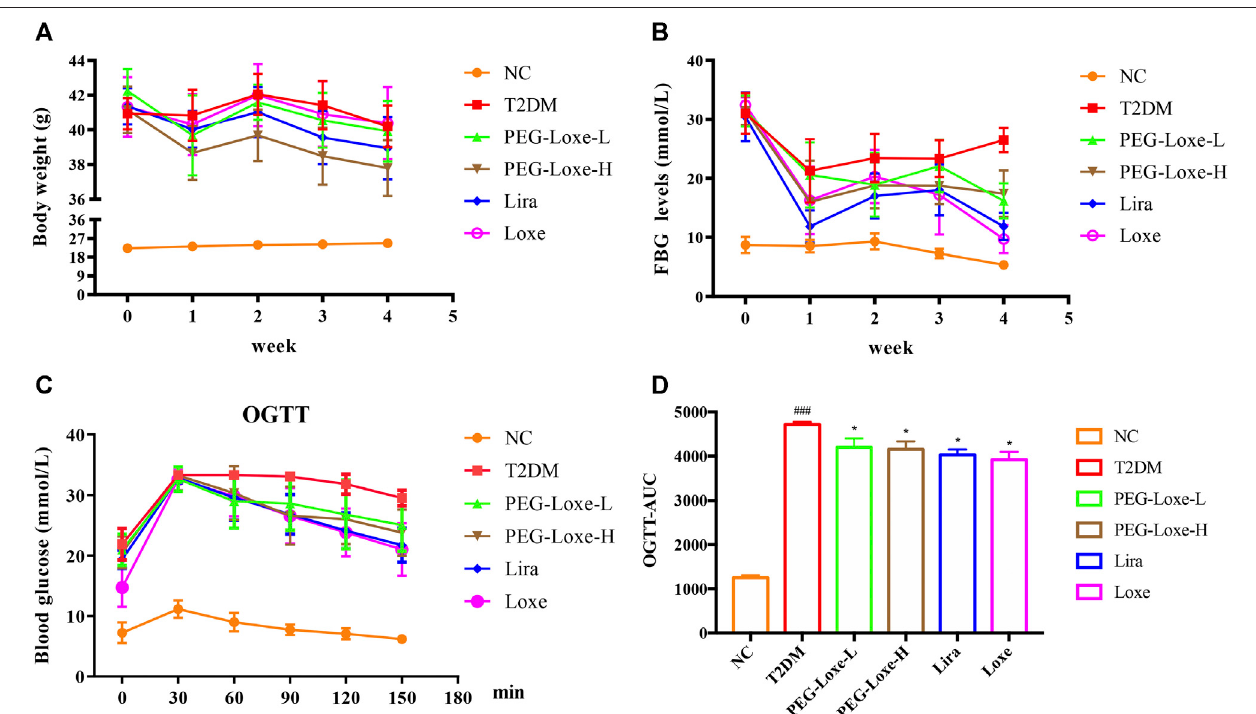
FIGURE 1 | Polyethylene glycol loxenatide (PEG-Loxe) reduces body weight and hyperglycemia in db/db mice (A) Changes in body weight after PEG-Loxe treatment over 4 weeks (B) Changes in fasting blood glucose (FBG) levels after PEG-Loxe treatment over 4 weeks (C) Oral glucose tolerance test (OGTT) test (D) The areaunderthecurve(AUC)ofOGTT.Dataareexpressedasthemean ± SD(n (cid:2) 8). ### p < 0.001comparedtothenormalcontrolgroup;* p < 0.05comparedtotheT2DM group.